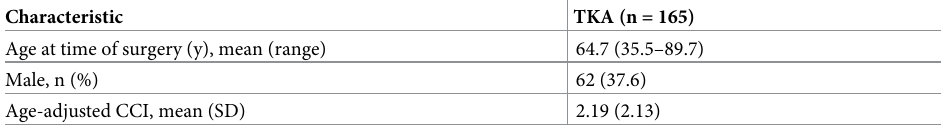
Table 1. Demographics of patients included in the